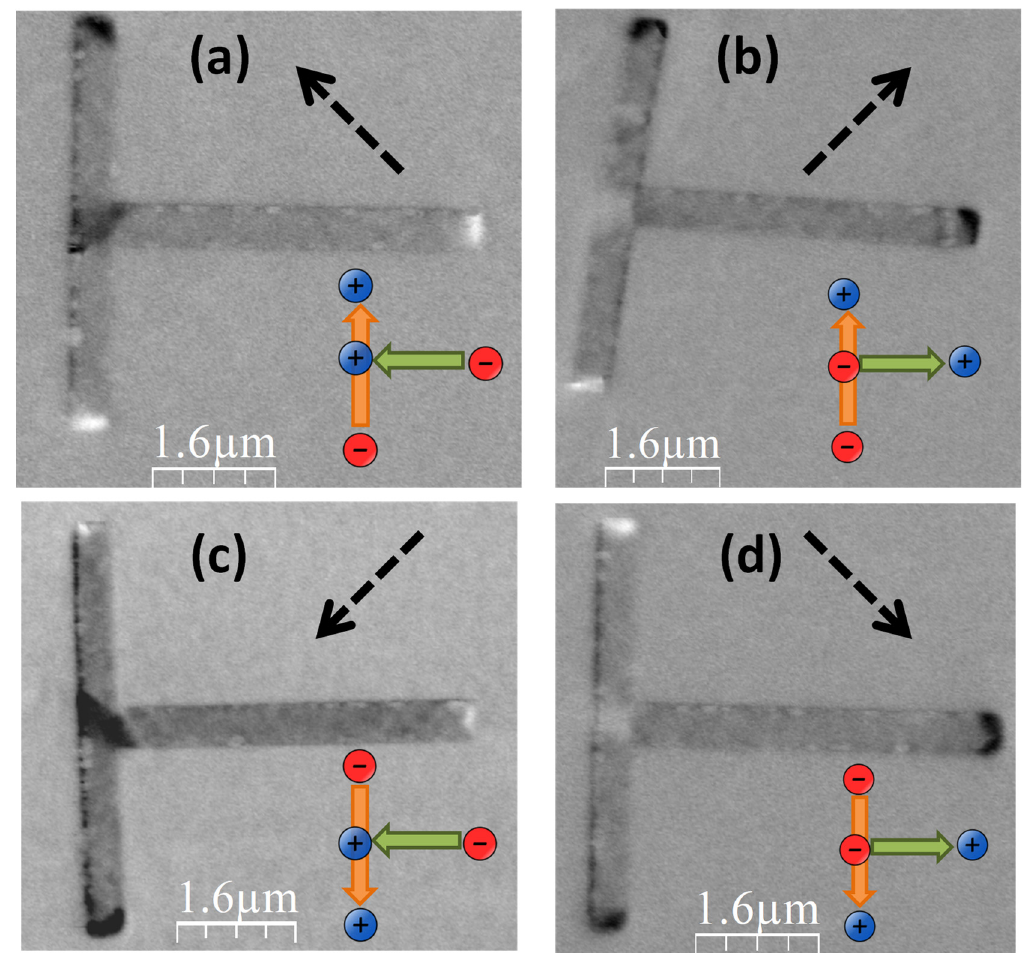
Figure 3. Magnetic Force Microscopy (MFM) images of the four different remanent states obtained in T-shaped structures after saturating them with fields applied along the four directions depicted with dashed black arrows. The arrow insets show the orientation of the magnetization in the two branches of the T in each case. Labelled as [ m x , m y ]: ( a ) [ − 1, 1] ( b ) [1, 1] ( c ) [ − 1, − 1] ( d ) [1, − 1].